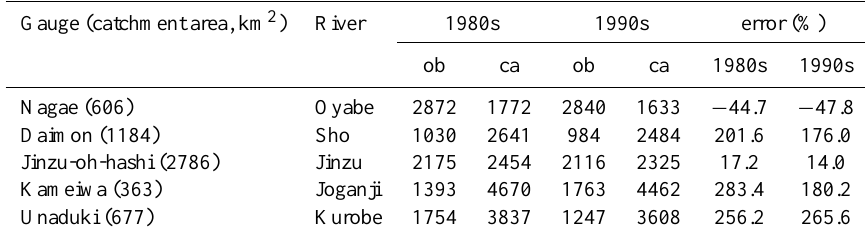
Table 2. Ten-year average runoff (mm) and relative error between observations (ob) and estimations (ca) for the five rivers.